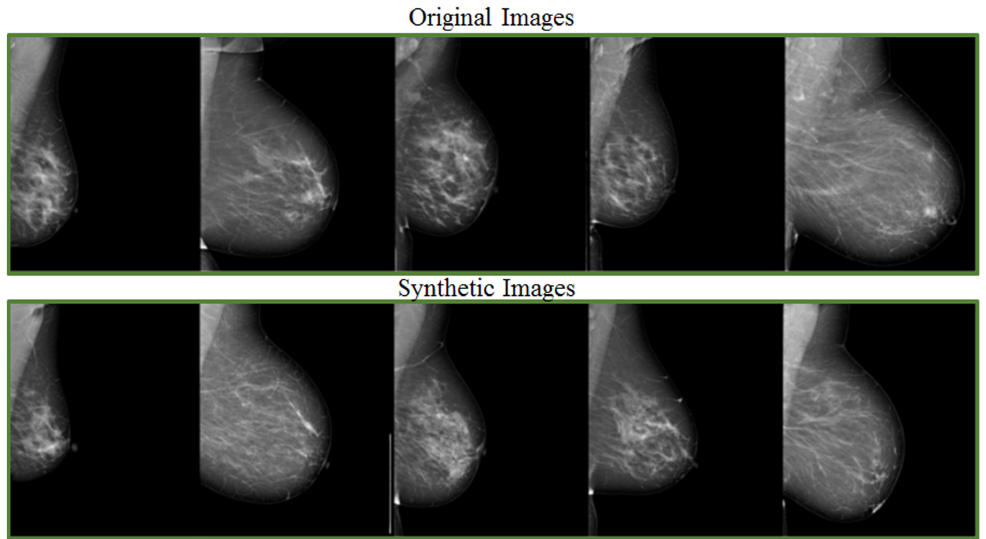
Figure 10. Randomly sampled examples of original and synthetic mammograms